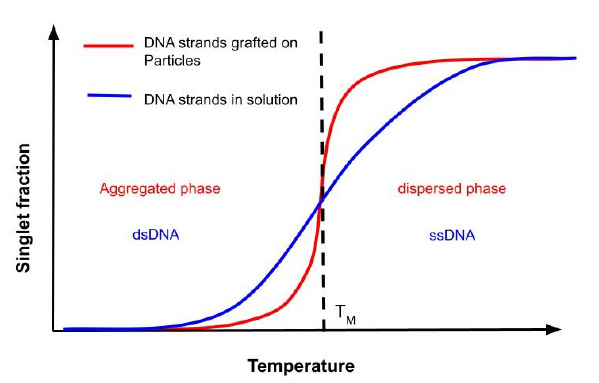
Figure 4. Representative melting profile of DNA-grafted particles (shown in red), and of DNA strands in solution (shown in blue). T M is the temperature at which half of the bases pair up. Below T M , DNA grafted particles aggregate and make an assembly whereas, above T M , particles disperse. The free DNA strands in solution form a duplex below T M . From the figure one can see that the transition from dispersed to aggregated phase is much sharper than the transition from single stranded DNA (ssDNA) to double stranded DNA (dsDNA)